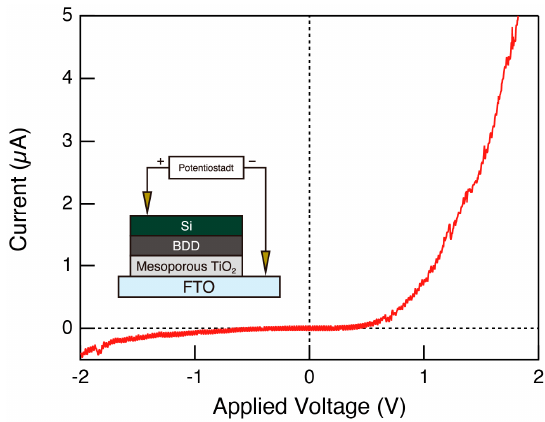
Figure 3. I–V characteristics of mesoporous TiO 2 /BDD heterojunction. Inset shows the schematic illustration of the experimental setup.